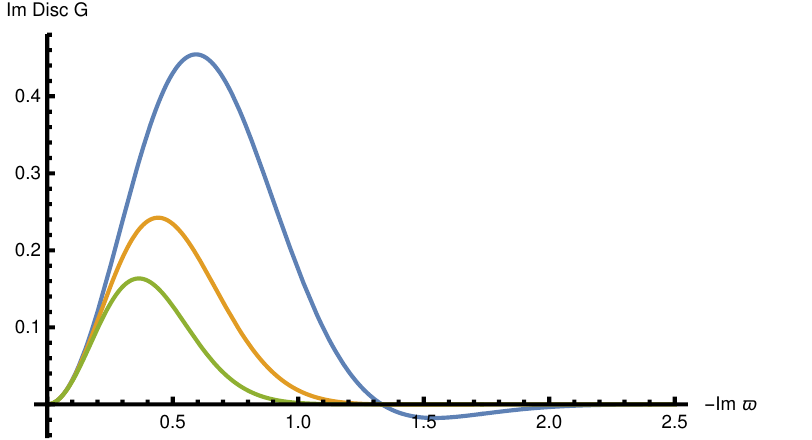
Figure 4 . The discontinuity of the transverse correlator of the energy-momentum tensor on the imaginary axis of the complex frequency plane in the extremal limit e Q → 1 at q = 0 . The blue, yellow, and green curves are for ξ = 10 , 20, and 30,